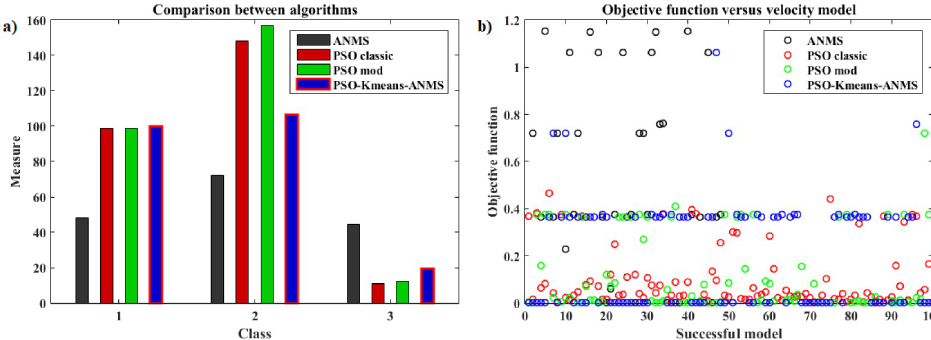
Fig 24. Case 1 (100 × 20). (a) Comparison between algorithms divided into: Class 1, success rates; Class 2, average CPU times and Class 3, average objective function values ( ϕ ( m ) × 10 2 ). (b) Objective function values for successful models.